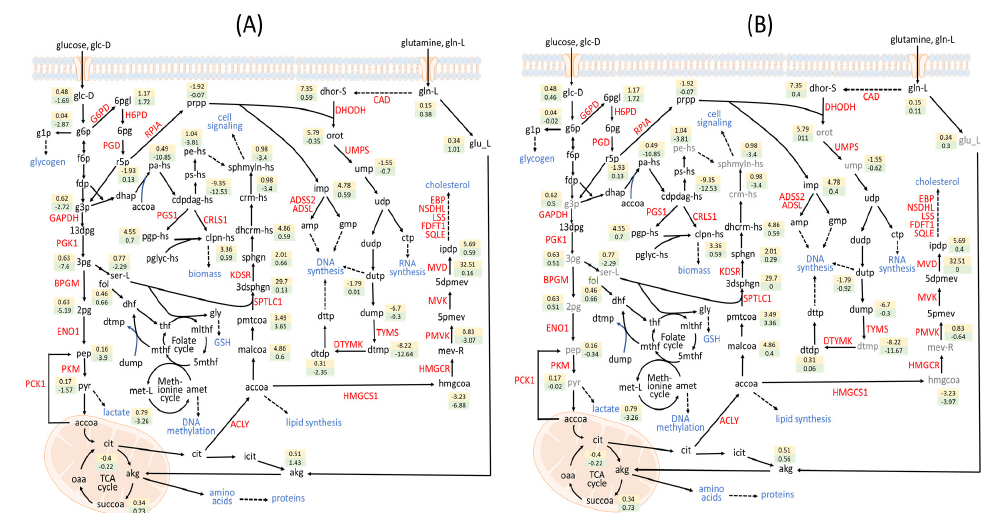
Figure 6. Mean fold changes of metabolite-flows for perturbed cases and the template. The log fold changes of metabolite-flows for the identified targets in ( A ) the first group and ( B ) the second group. The identified gene-encoding enzymes are represented in red. The identified antimetabolites are presented in gray. The values in yellow boxes denote log BL ( r CA ) for the template, whereas the green box displays log log m / r m 2 A positive value indicates that the metabolite-flow of cancer cells or the perturbation is higher than basal. A negative value represents lower